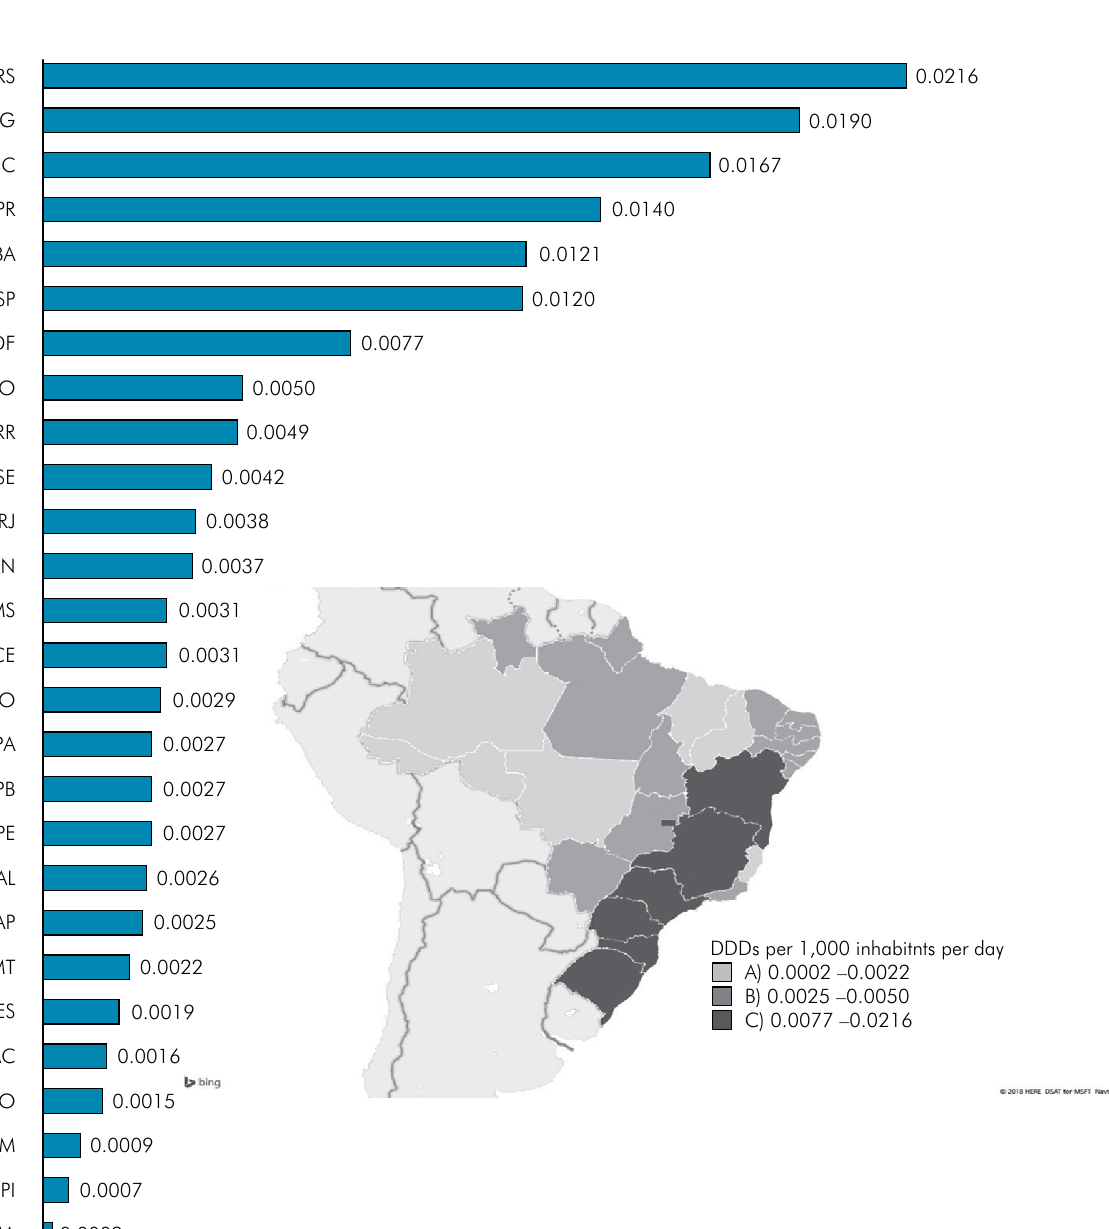
Figure. Distribution of DDDs per 1,000 inhabitants per day by Brazilian